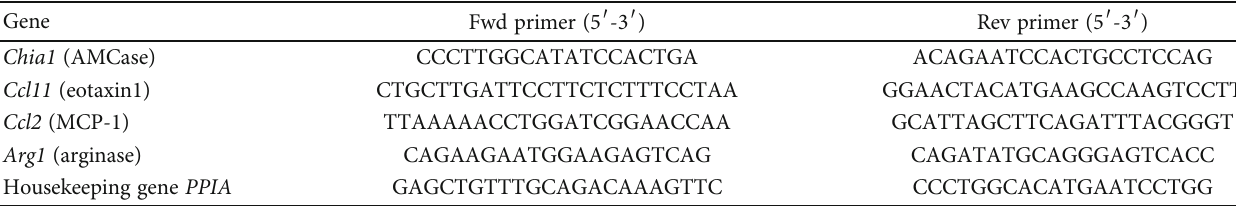
Table 1: Sequences of